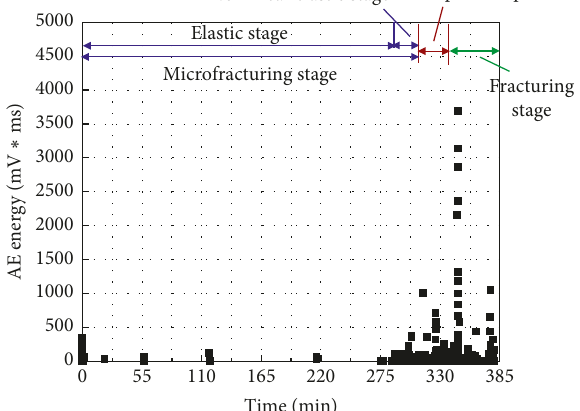
Figure 13: Scatter diagram showing the distribution of the AE energy detected during the static fracturing of the layered concrete